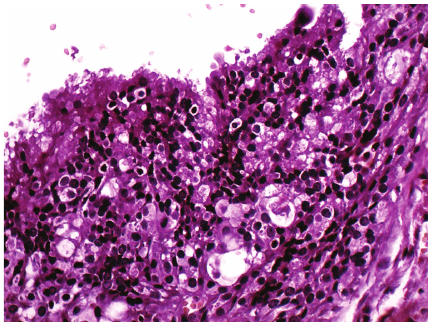
Figure 3: Mucous cells were frequently seen ( × 400).